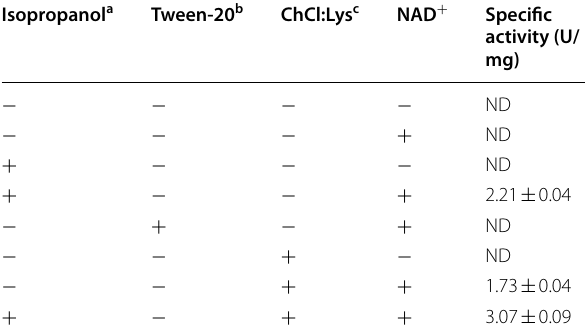
Table 3 Redox specific activities of cell-free extract on different additives and NAD